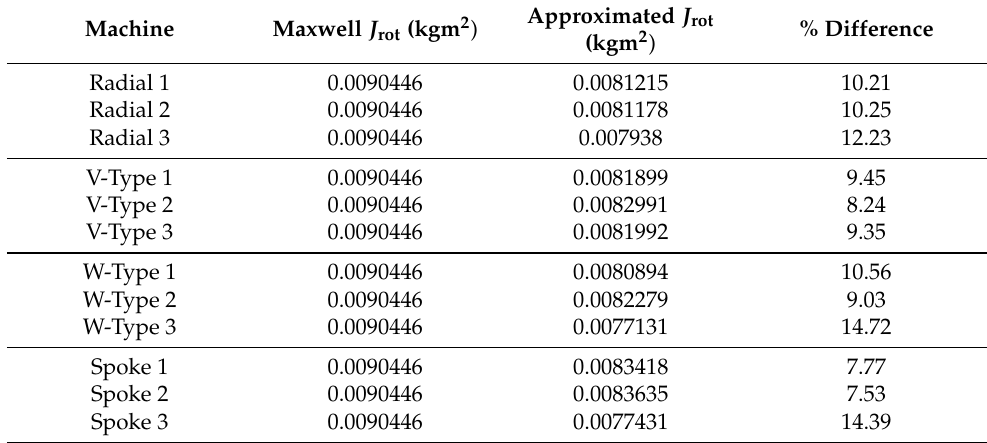
Table 5. Approximate and Maxwell rotor